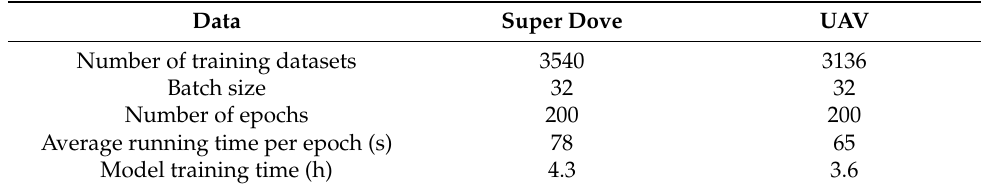
Table 2. Statistics of the time required for VGGUnet model training.